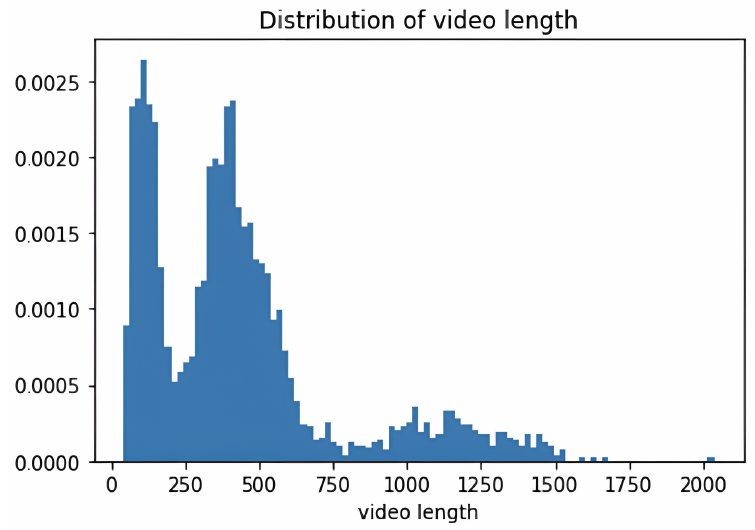
Figure 3. Distribution of video length.